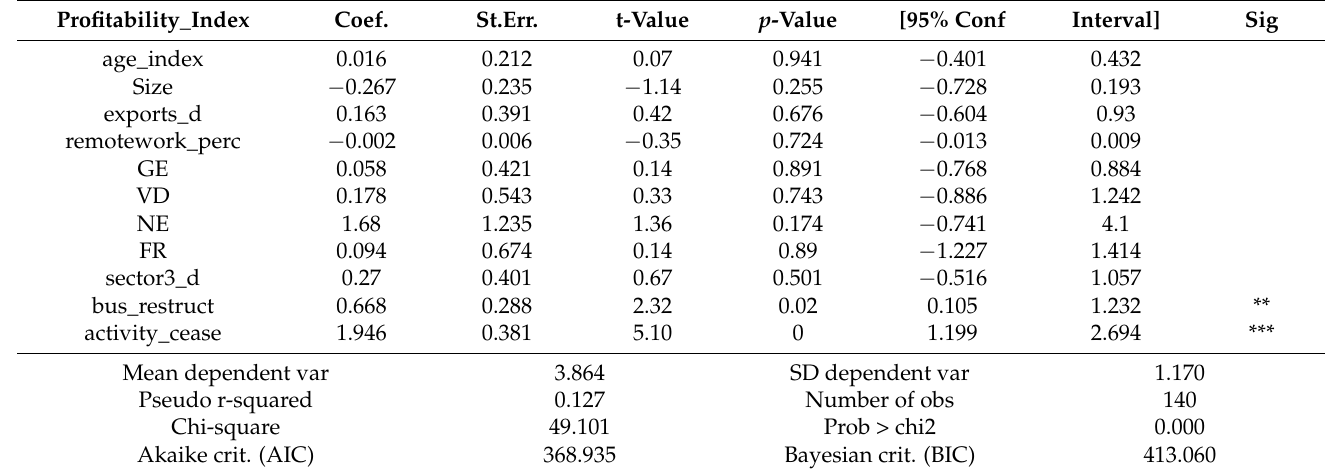
Table 8. Ordinal logit model results with profitability index.